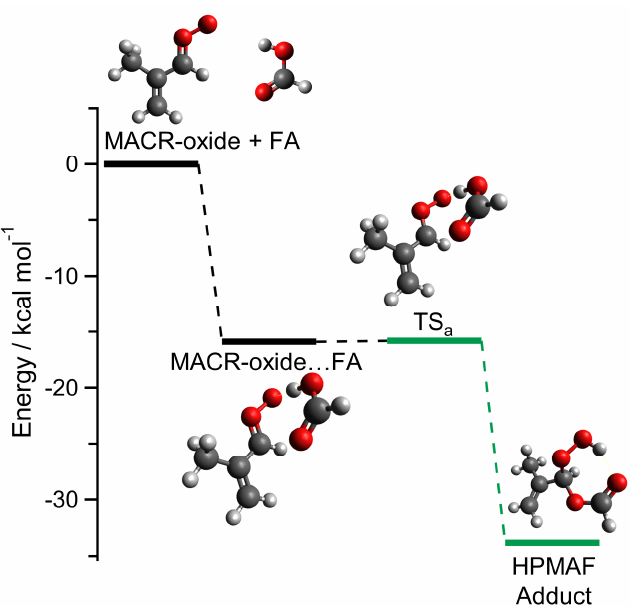
Figure 3. Reaction coordinate showing HPMAF formation from the 1,4-addition reaction of anti - trans- MACR-oxide with formic acid (FA, green) at the CCSD(T)-F12/cc-pVTZ-F12//B2PLYP-D3/cc-pVTZ level of theory including estimated CCSDT(Q) corrections.